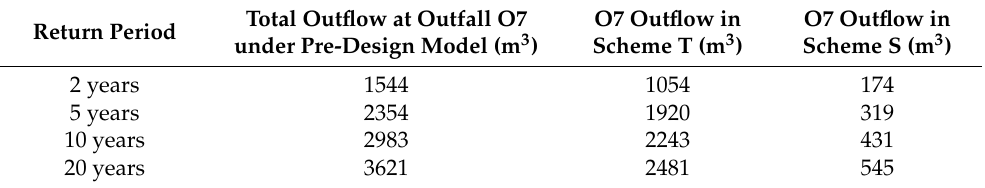
Table 5. O7 Outflow in the pre-design scheme, Scheme S and Scheme T under rainfall events of different return